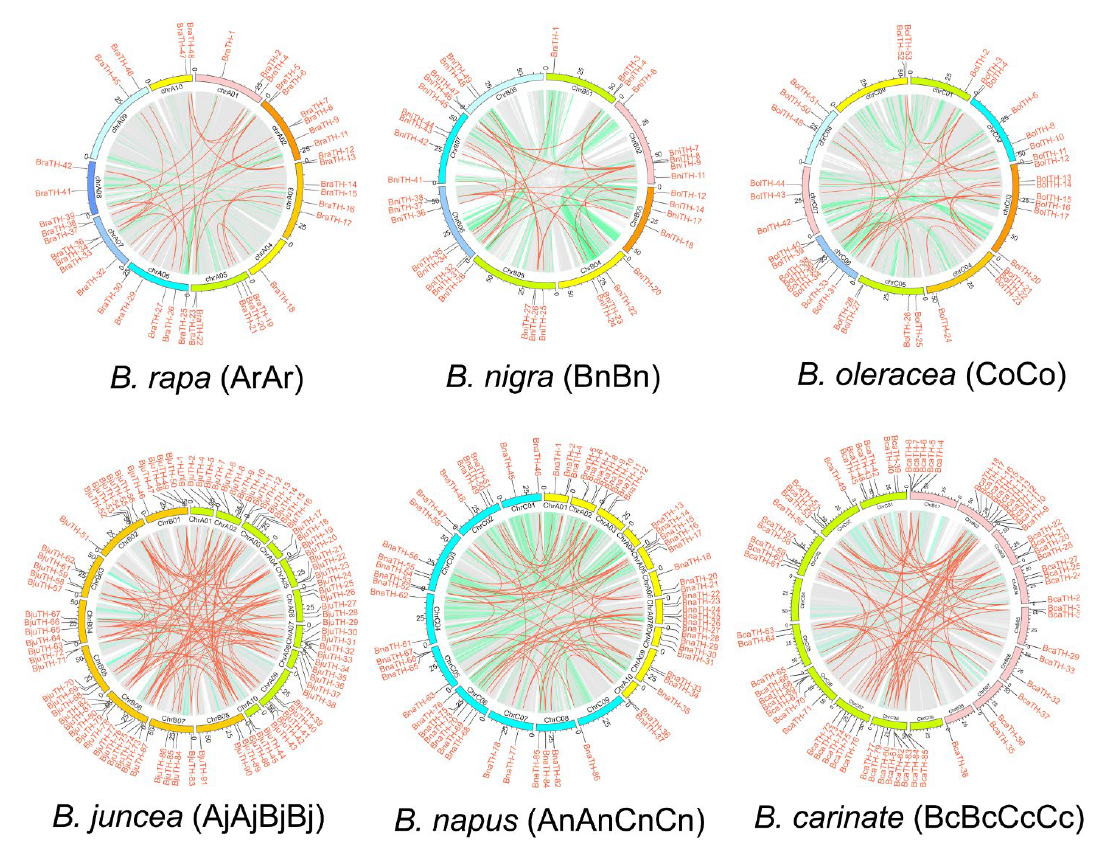
Figure 4. The collinearity of TH genes in B. rapa , B. nigra , B. oleracea , B. juncea , B. napus , and B. carinate . The green line indicates all synteny blocks between each chromosome and the red line indicates duplicated TH gene pairs. The chromosome number is shown at the top of each chromosome. The scale marked on the chromosome indicates the chromosome length (Mb).